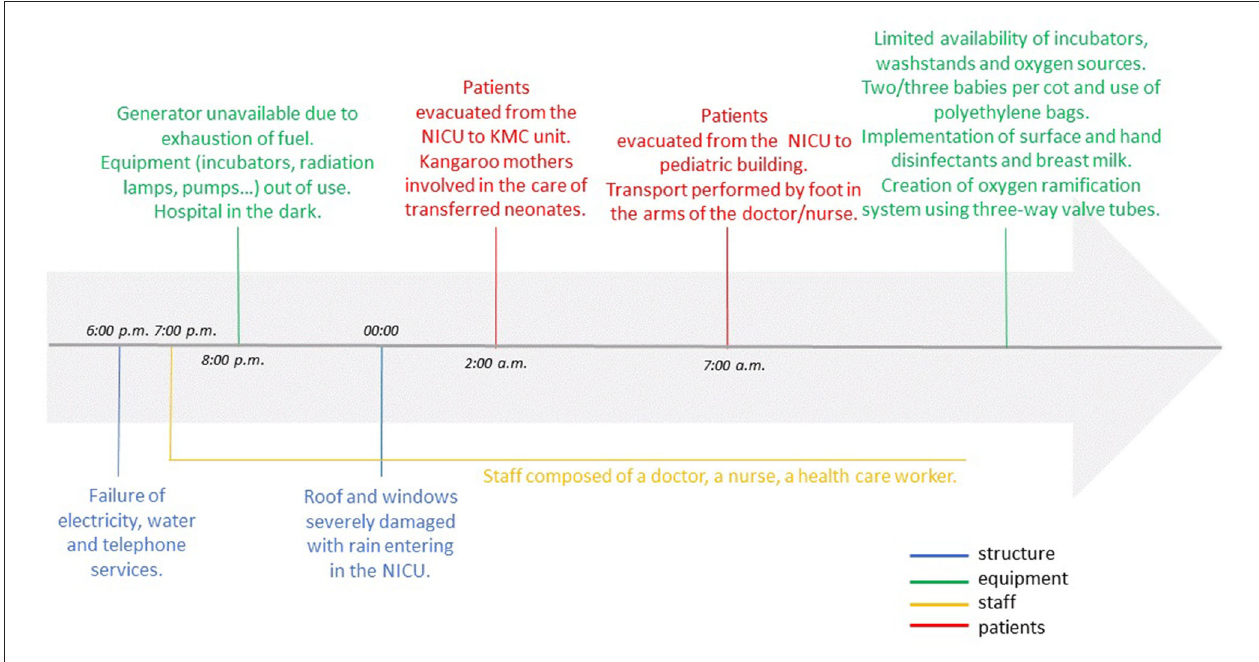
FIGURE 1 | Time line of events and interventions.